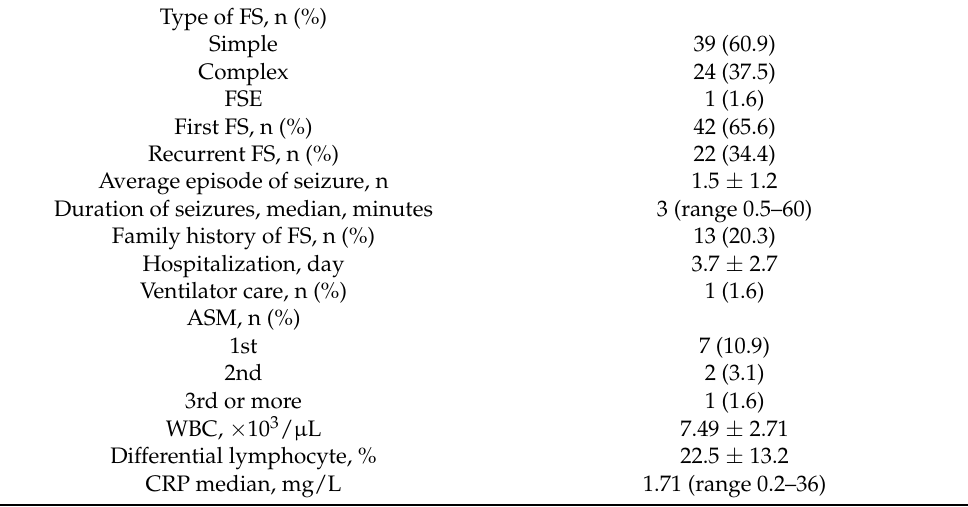
Table 2. Clinical manifestations in children with COVID-19-associated febrile seizures.